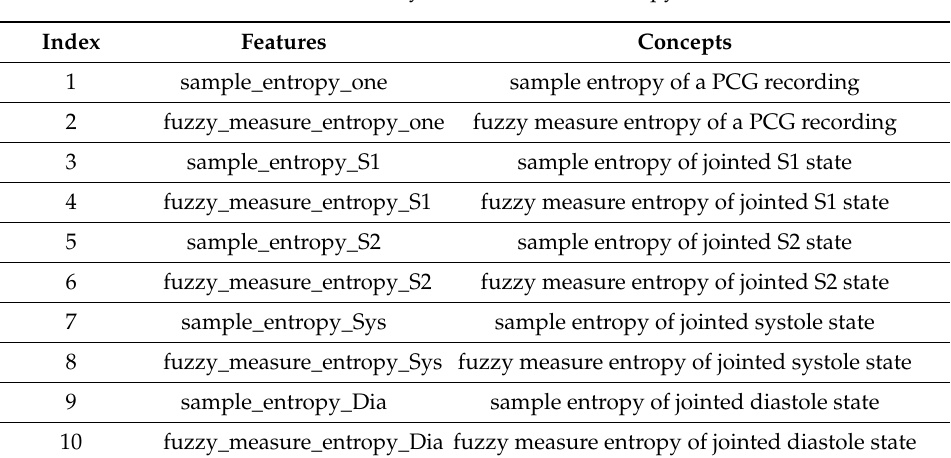
Table A6. The summary of the features in entropy